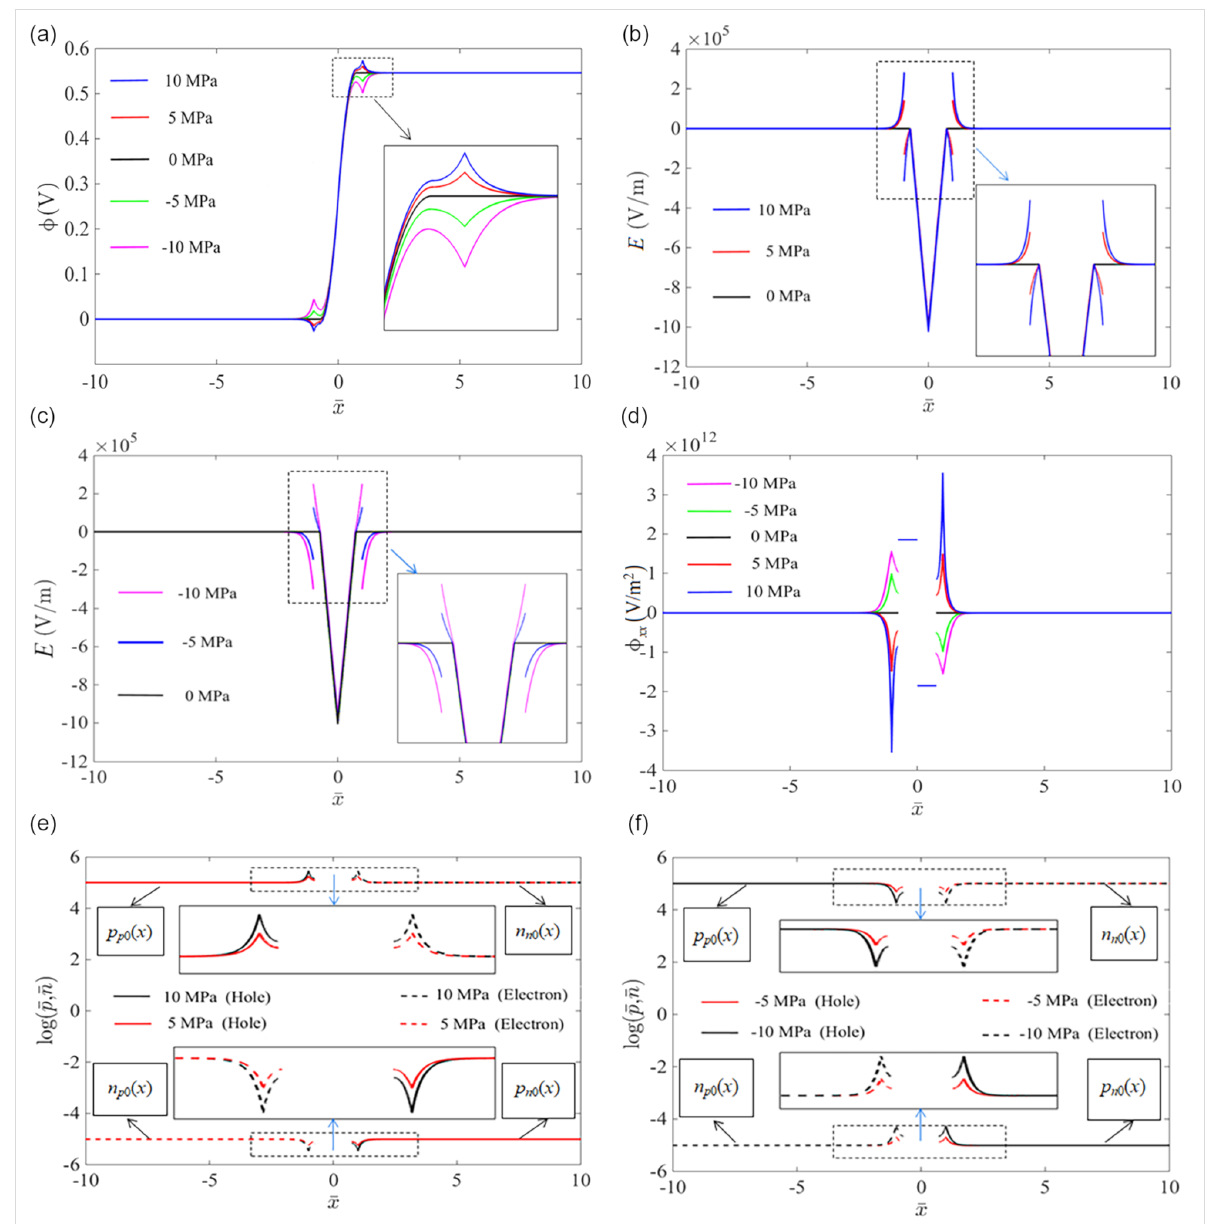
Figure 2: Quasi-electrostatic analysis of a mechanically loaded piezoelectric p–n junction under a bias voltage: (a) electric potential; (b) electric field under tensile stress; (c) electric field under compressive stress; (d) the second derivation of electric potential; (e) carrier concentrations under tensile stress; (f) carrier concentrations under compressive